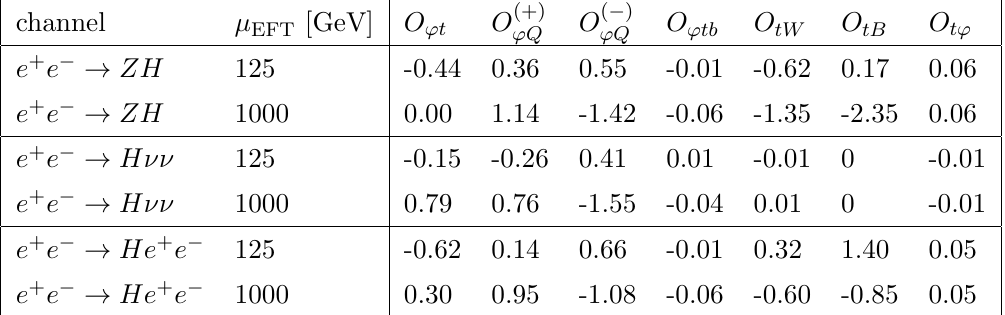
H(cid:23)(cid:23) !